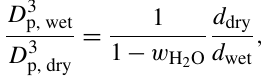
Table 3. Properties of primary and aged SVOCs. Surrogate MW a K pb